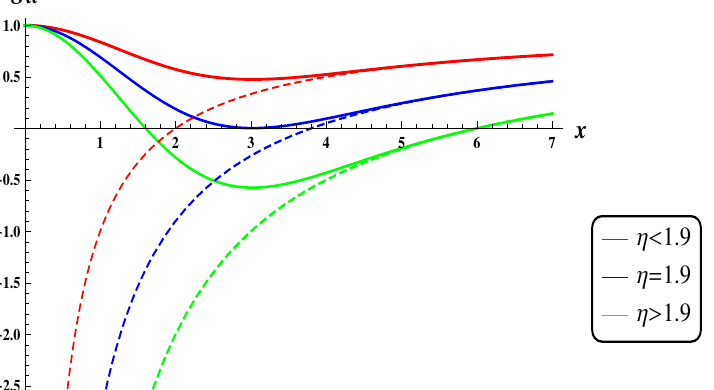
Figure 7. g tt in terms of x for various values of M √ event horizon(s). The dashed curves show the commutative case for different values of mass M